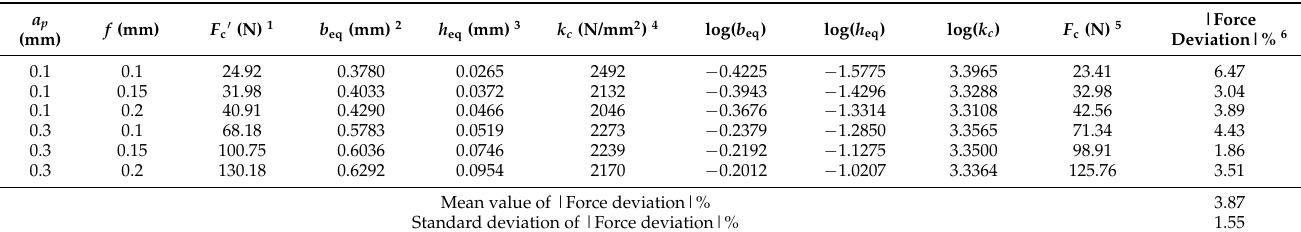
Table 8. The fine turning parameters of low carbon steel S15C and the cutting forces, wherein the nose radius of insert ( r e ) is 0.4 mm, the cutting edge angle ( κ ) is 1.6232 rad (93 ◦ ).